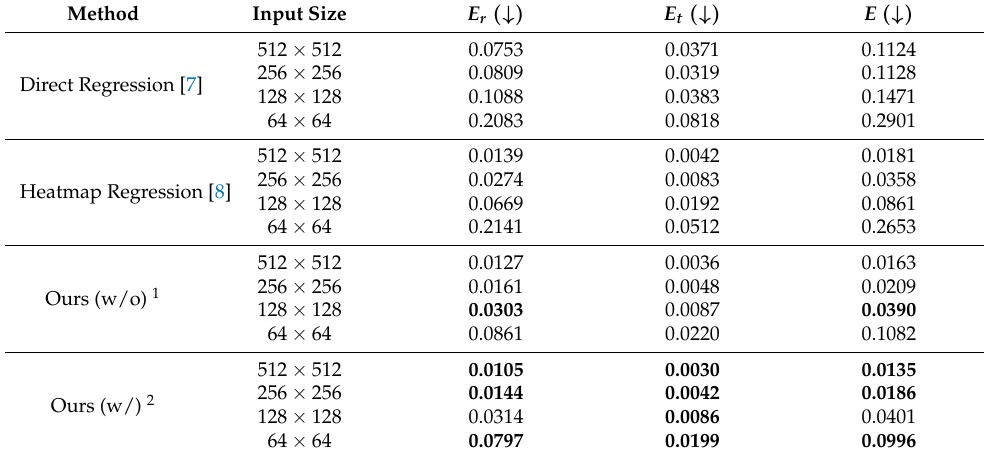
Table 3. Comparison with the state-of-the-art methods for space target pose